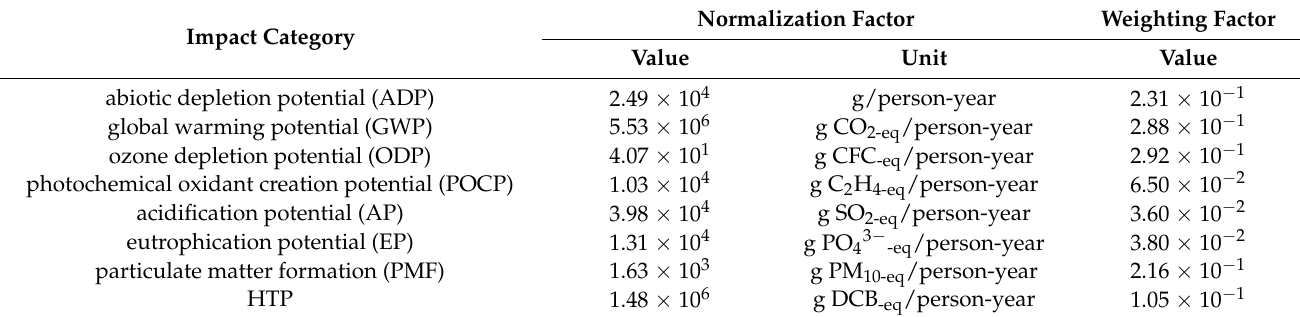
Table 5. Normalization and weighting factors of impact categories